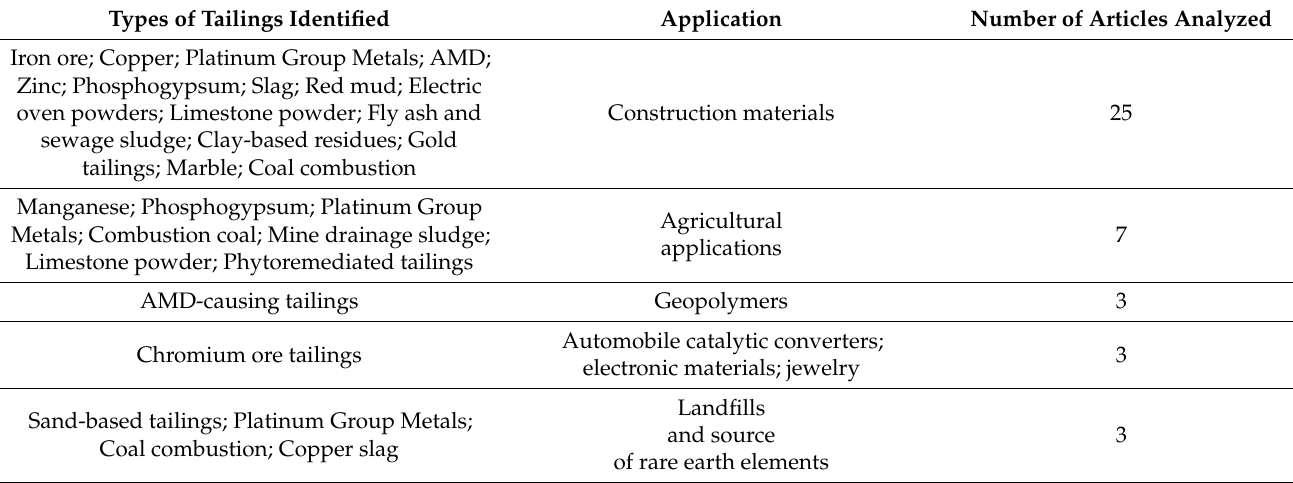
Table 2. Tailings identified and their